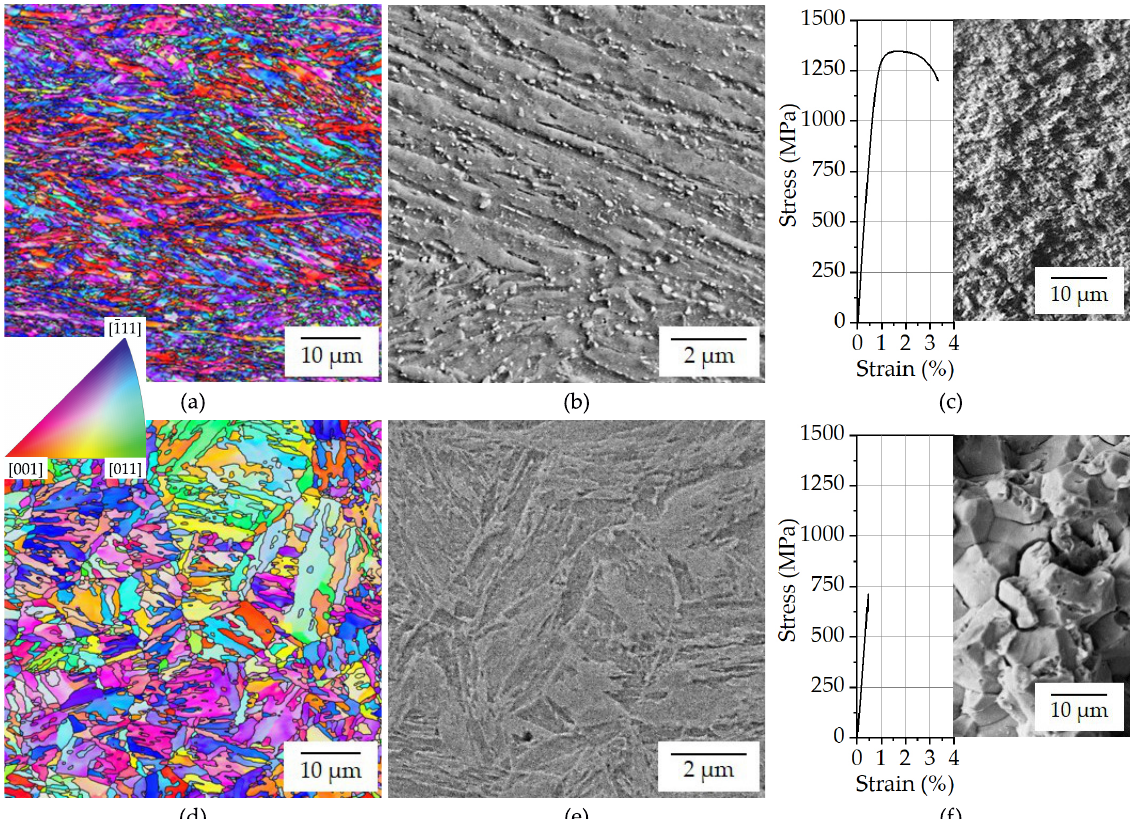
Figure 6. ( a ) IPF map of the cold-rolled state; ( b ) SEM image of the cold-rolled state containing small carbides; ( c ) tensile test results in combination with phase map (blue = bcc) and fracture surface of the cold-rolled state; ( d ) IPF map of the as-quenched state; ( e ) SEM image of the martensitic as-quenched state; ( f ) tensile test results in combination with phase map (blue = bcc) and fracture surface of the as-quenched